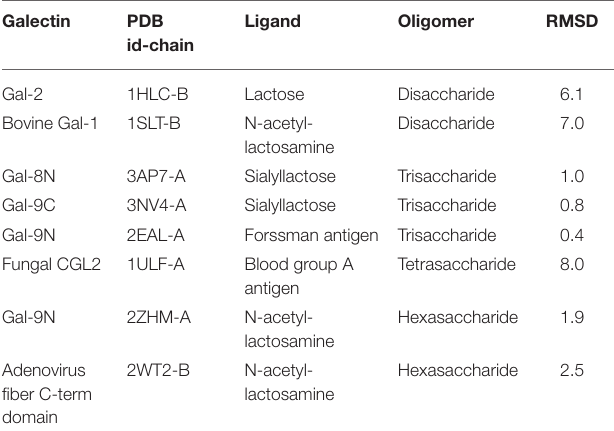
TABLE 1 | Docking results of carbohydrates of different sizes onto their respective Galectin receptors, using Autodock Vina Carb.